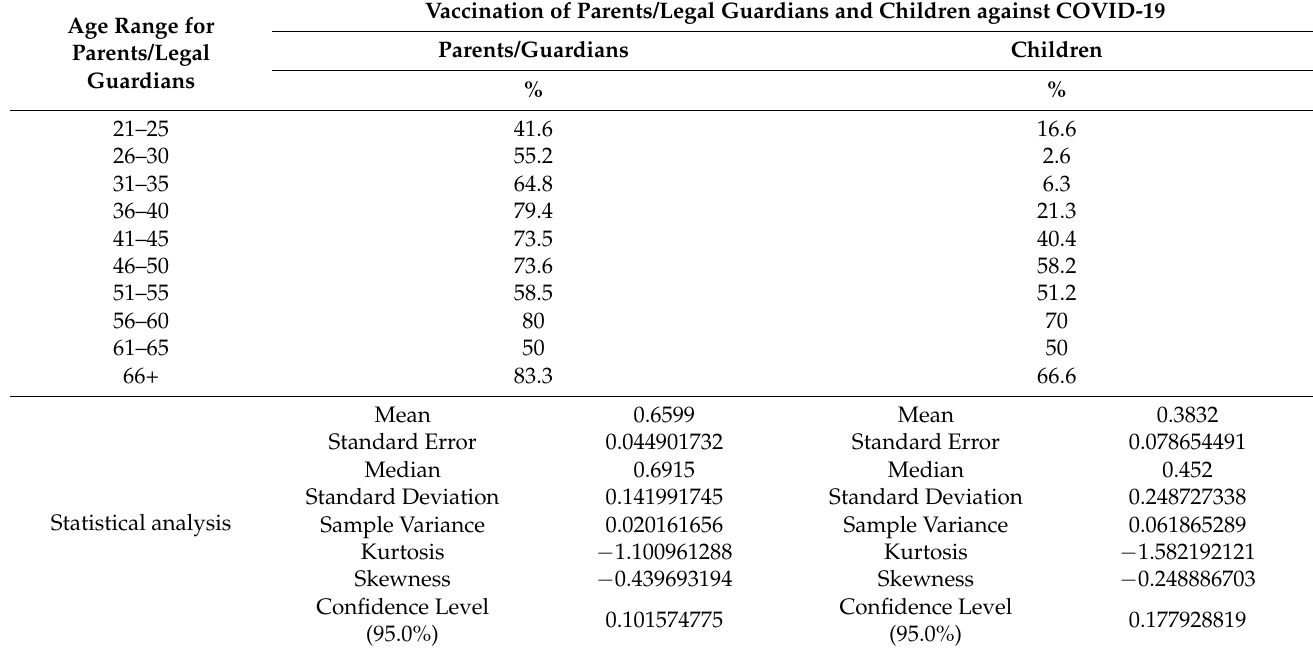
Table 6. Schedule of anti-COVID-19 vaccination of parents and their children.